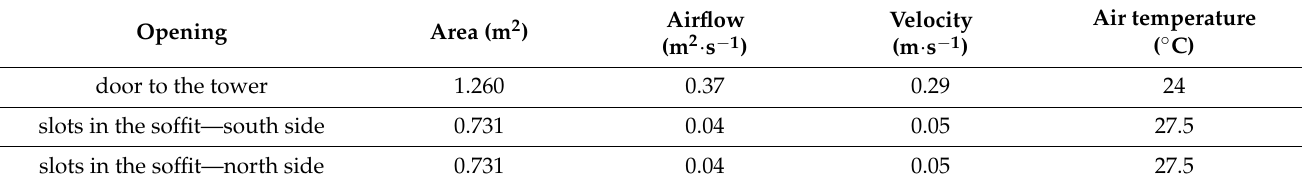
Table 3. Airflow characteristics through the openings at 12:00 a.m. obtained from BPS simulation. Opening door to the tower slots in the soffit—south side slots in the soffit—north